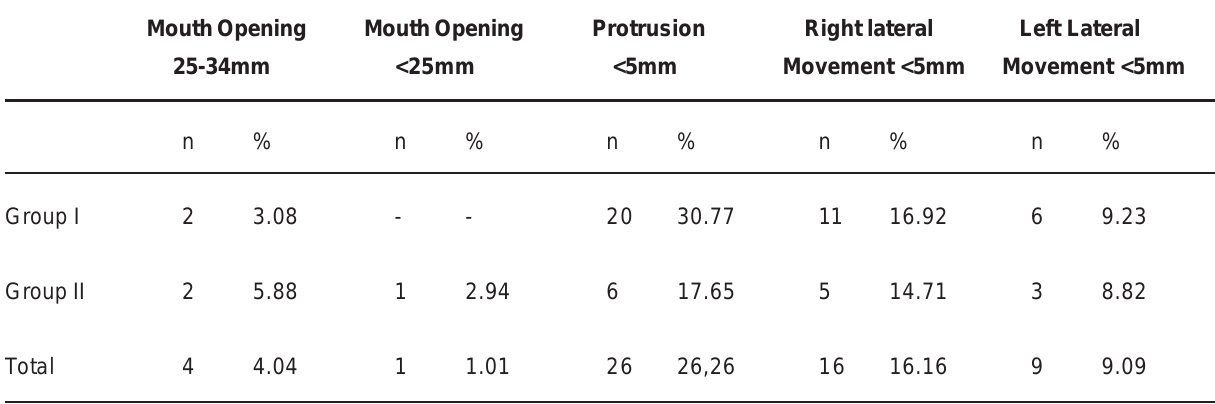
TABLE 3 - Number and percentage of subjects with restricted movements in both